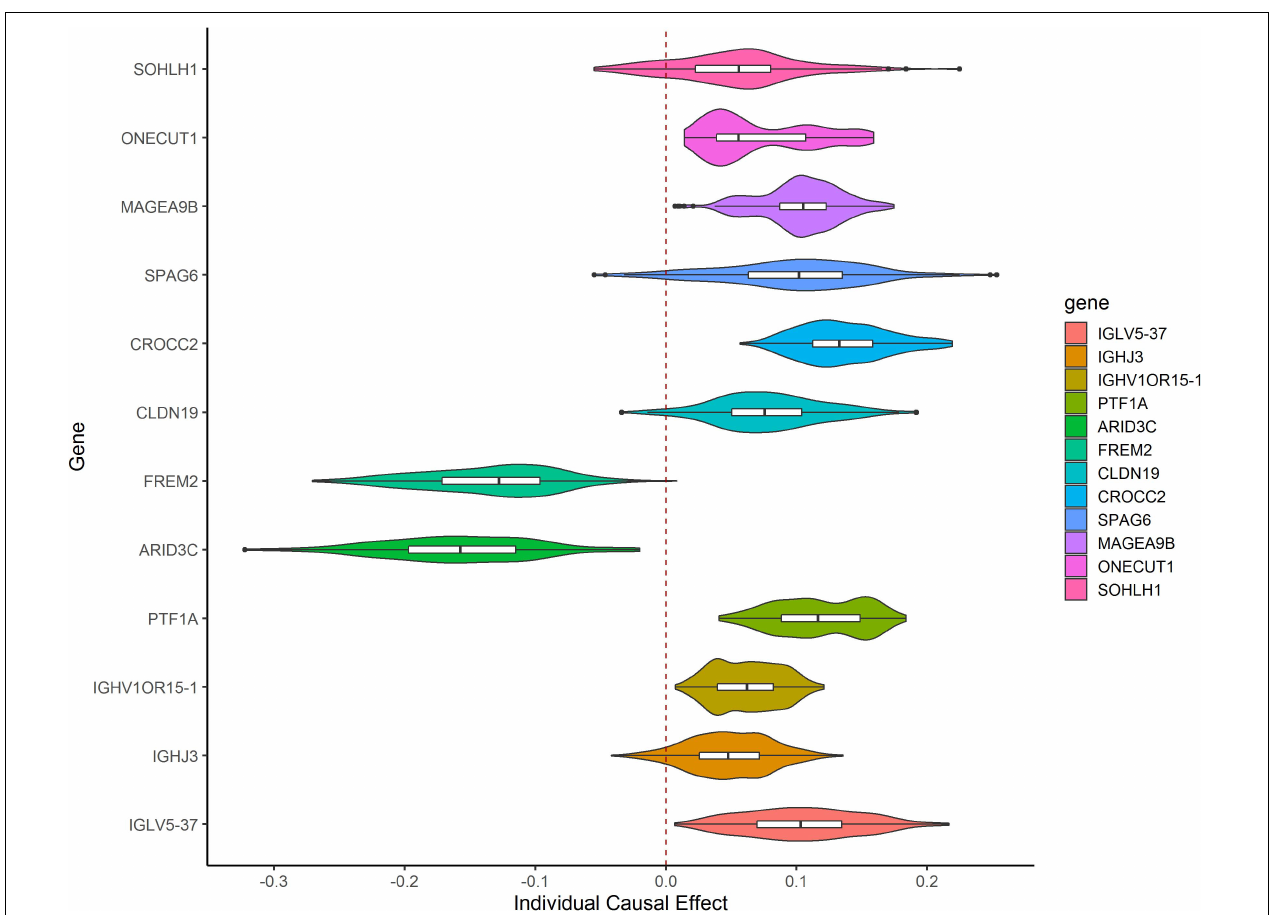
FIGURE 3 | Violin plot showing IE estimates the distribution of 12 candidate genes. IE was calculated as the marginal risk difference of 3-year mortality for each OSC patient with high gene expression versus low gene